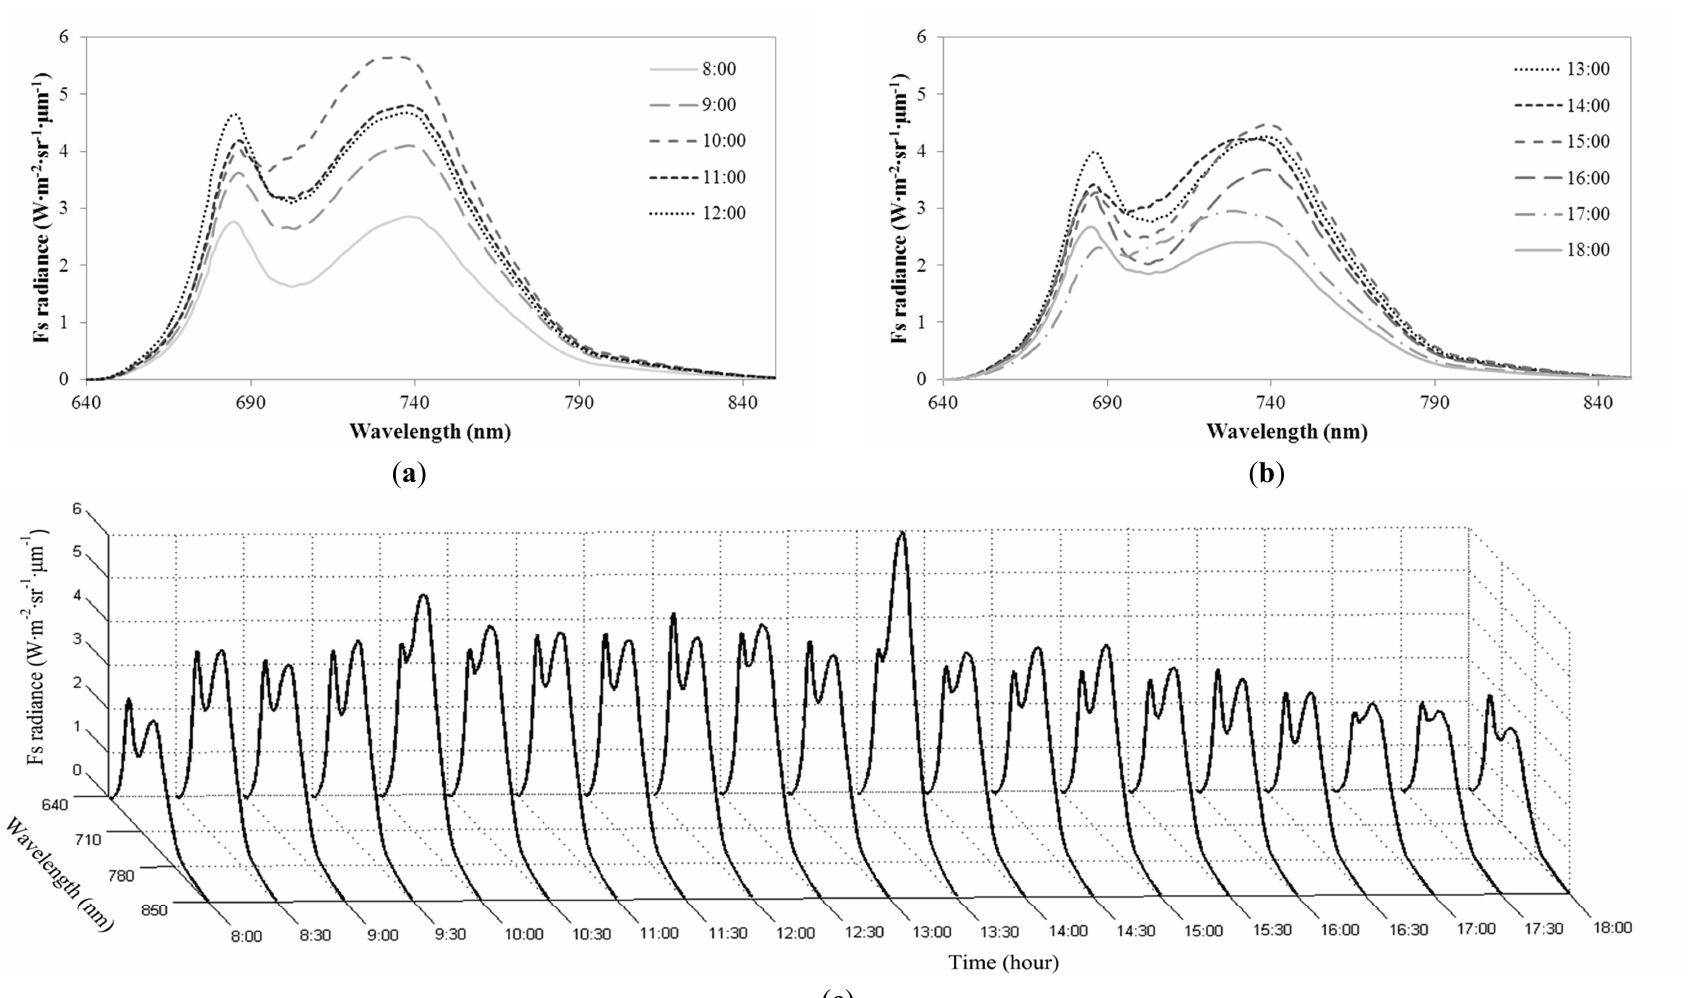
Figure 6. Diurnal variation of the reconstructed spectra of the solar-induced chlorophyll fluorescence. ( a ) From the morning to noon (at